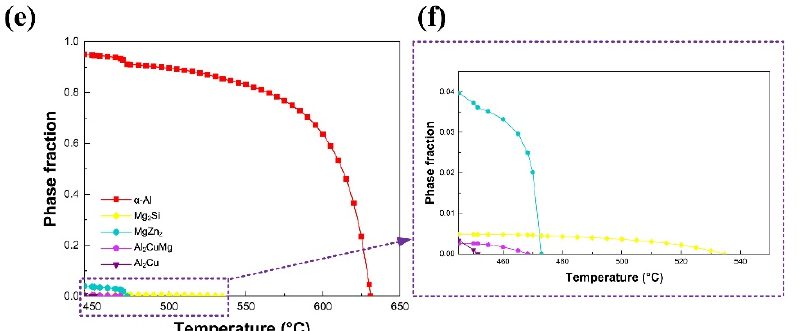
Figure 8. The phase evolution data during solidification process of typical welds: ( a ) The AA7075/Al-Cu4.5-Si1.5 weld; ( b ) the magnification of ( a ); ( c ) the AA7075/Al-Cu1.5-Si4.5 weld; ( d ) the magnification of ( c ); ( e ) the AA7075/Al-Cu2.3-Mg2.3-Zn6.6 weld; ( f ) the magnification of ( f ).